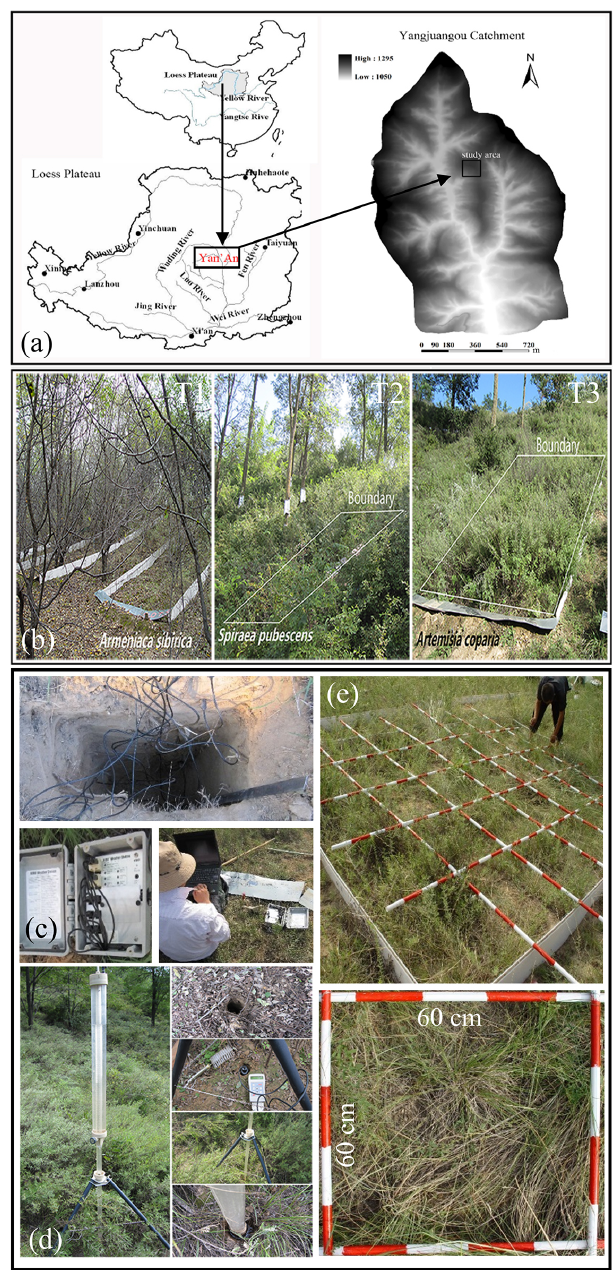
Figure 2. Study area and experimental design: (a) location of the Yangjuangou Catchment; (b) three restoration vegetation types including Armeniaca sibirica (T1), Spiraea pubescens (T2) and Artemisia copria (T3); (c) the dynamic measurement of soil mois- ture and data collection to provide the information about average antecedent soil moisture; (d) the measurement of field-saturated hy- draulic conductivity to determine the average infiltration capability; (e) investigation of the morphological properties of restoration veg- etation by setting